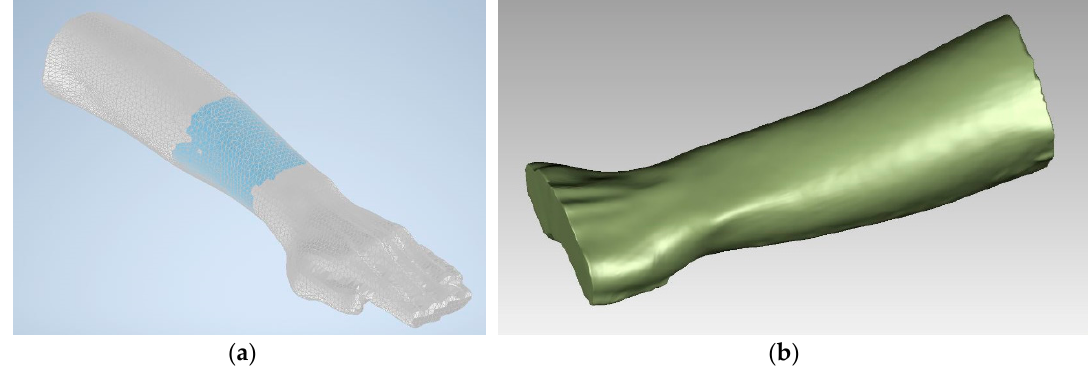
Figure 3. Post processed: mesh of the scanned arm ( a ) and solid digital model obtained from the clean mesh ( b ).